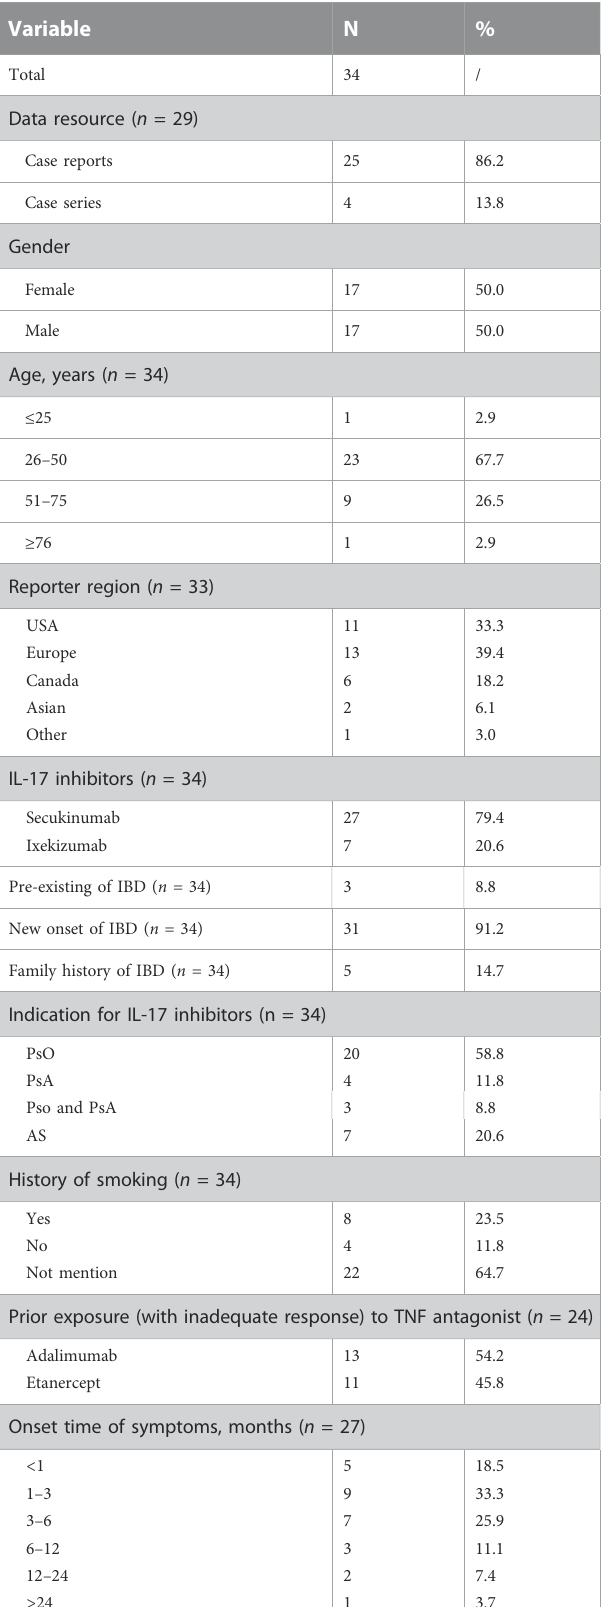
TABLE 4 Summary of demographic features of patients with interleukin (IL)-17 inhibitors-induced In fl ammatory bowel disease.